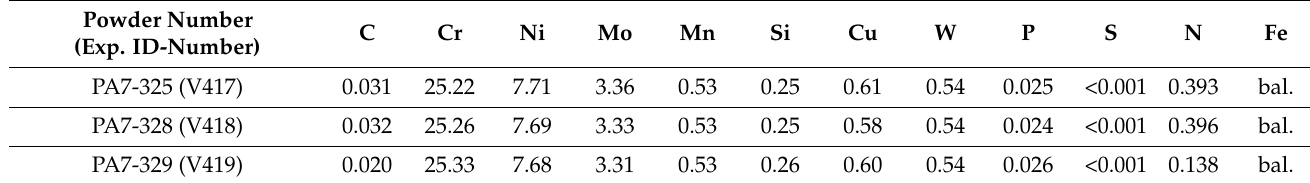
Table 9. Chemical composition of the as-built parts determined using S-OES (in mass %).